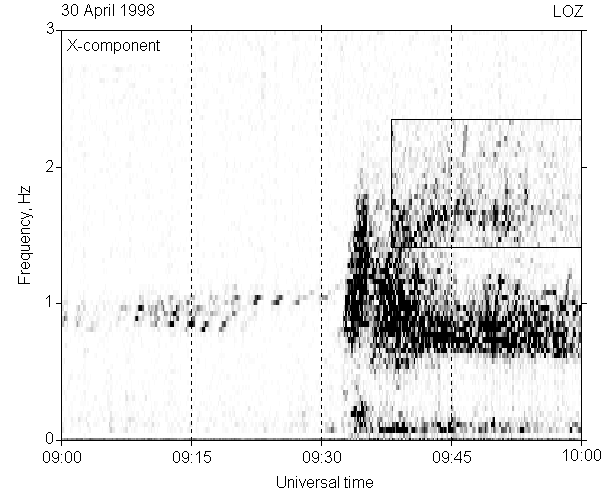
Fig. 4. Excitation of the ULF burst and the increase of the “pearls” carrier frequency during the magnetosphere